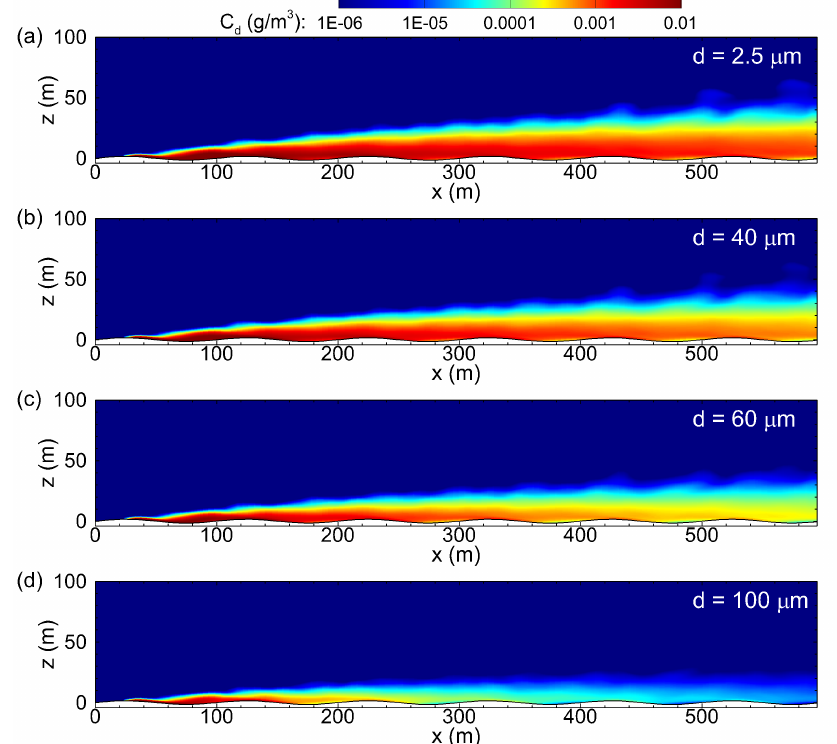
Figure 9. Time-averaged oil aerosol concentrations on the ( x , z ) -plane across the center of the surface release region for the plane-progressive wave case: ( a ) d = 2.5 µ m; ( b ) d = 40 µ m; ( c ) d = 60 µ m; ( d ) d = 100 µ